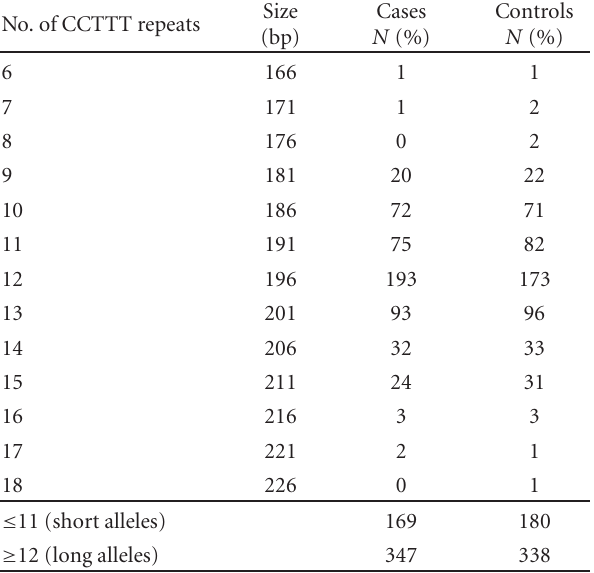
Table 1: Allele frequencies of the iNOS (CCTTT) n gene polymor- phism in cases and